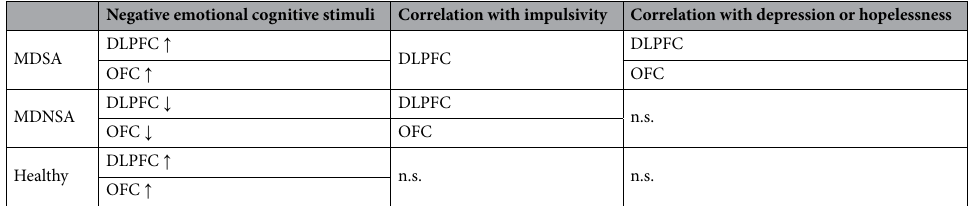
Table 2. Summary of results. MDSA mood disorder patients with a history of suicide attempt, MDNSA mood disorder patients with no history of suicide attempt, DLPFC dorsolateral prefrontal cortex, OFC orbitofrontal cortex, n.s. not